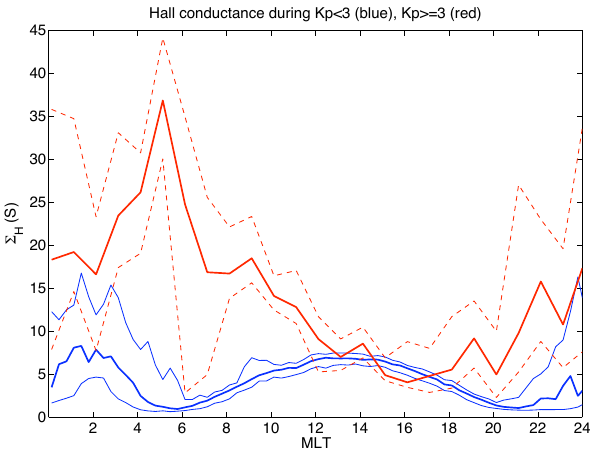
Fig. 4. Pedersen conductance for K p < 3 (blue) and for K p ≥ 3 (red). Thick lines indicate median values. The lower and upper quartiles are shown by thin blue lines for K p < 3.